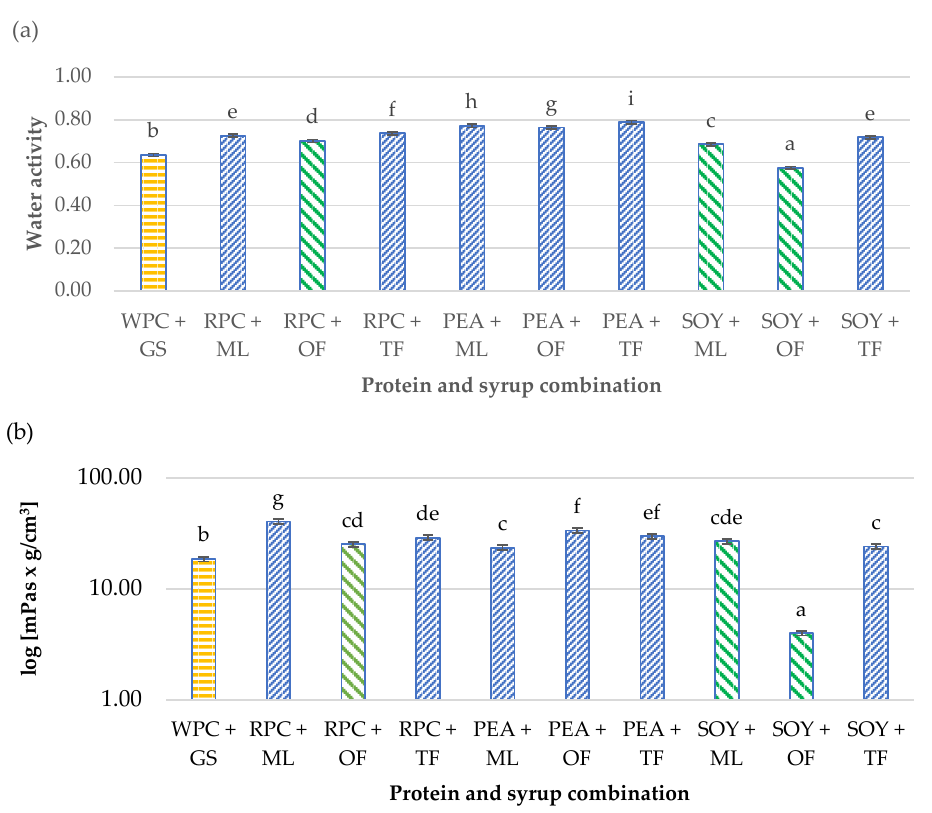
Figure 2. Influence of the combination of proteins and syrups on the ( a ) water activity (a w ) and ( b ) ultrasonic viscosity of the developed high-protein bars. The letters (a–i) indicate significant differences at p < 0.05 (Tukey’s HSD test). The control sample color is yellow. The best prognostic samples for both determinations are marked green. The a w tests were carried out in five repetitions ( n = 5) and ultrasonic viscosity in three replications ( n = 3).